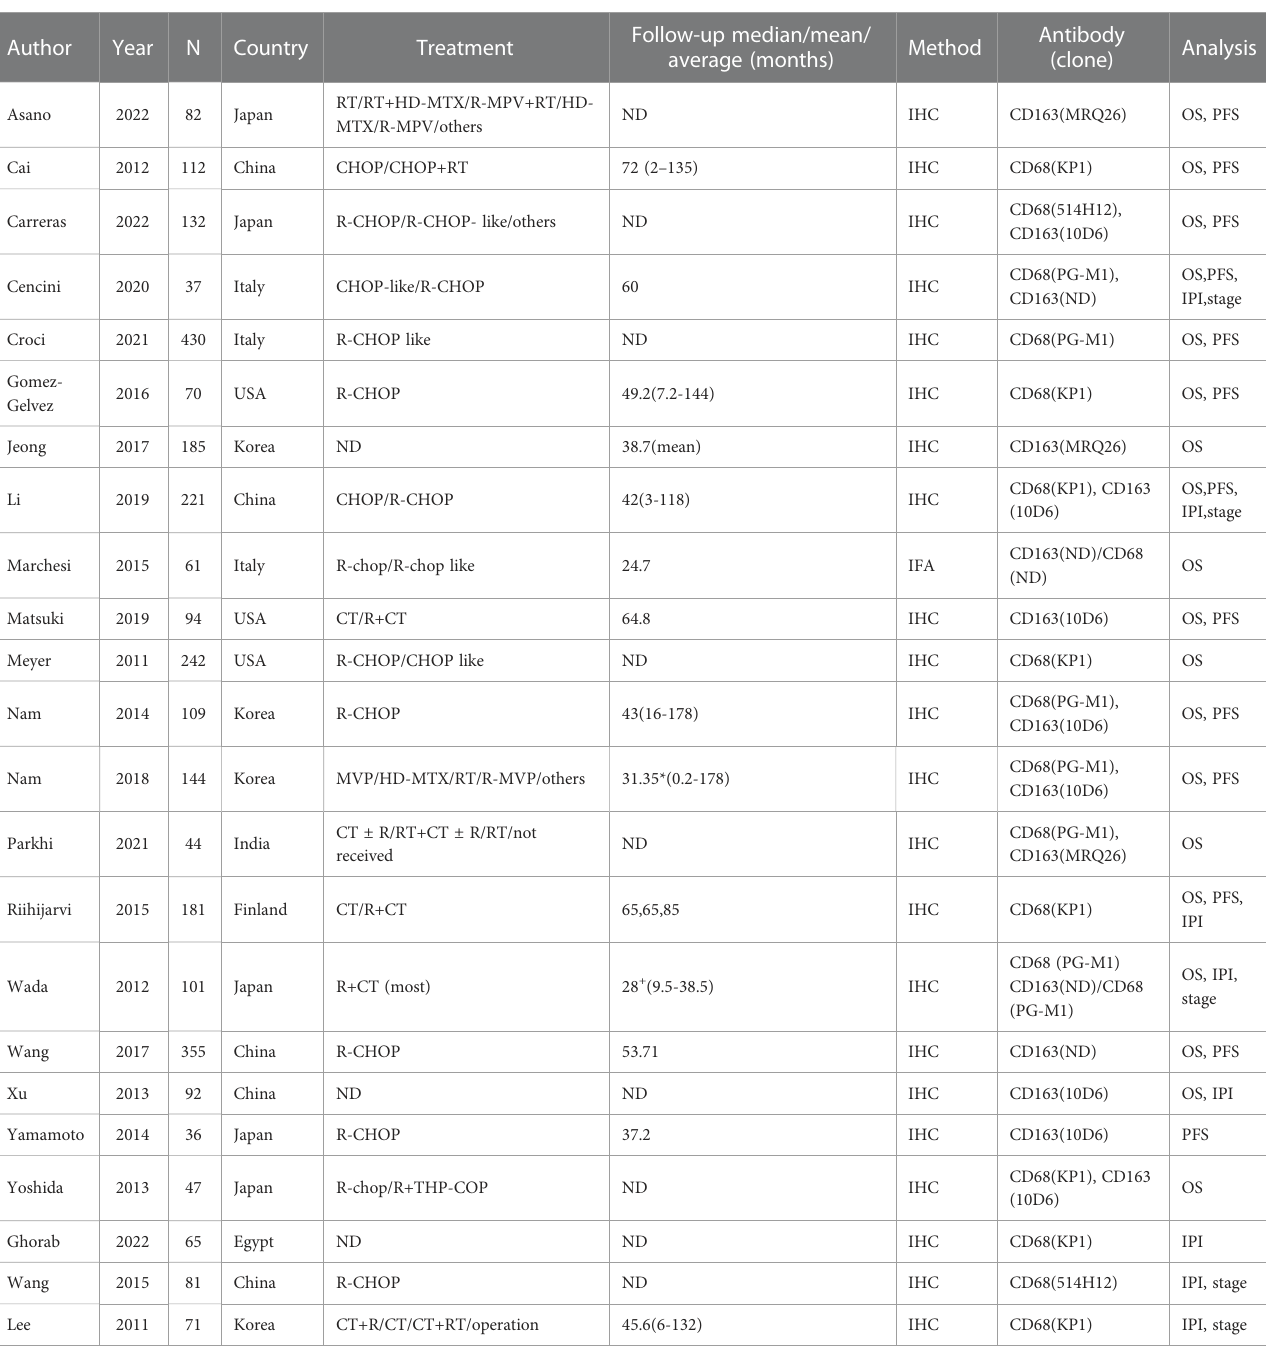
TABLE 1 Characteristics of the eligible